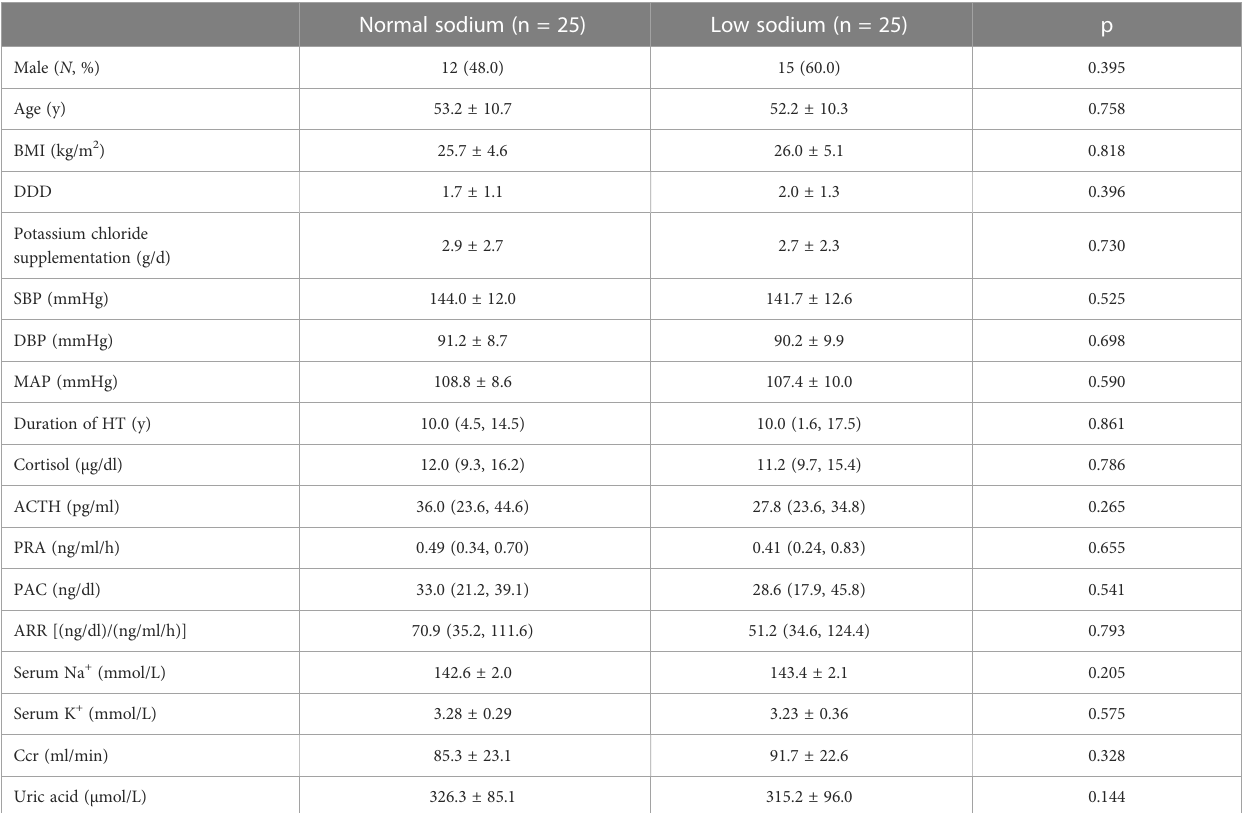
TABLE 1 Baseline characteristics of participants in the two groups. Normal sodium (n = 25) Low sodium (n =